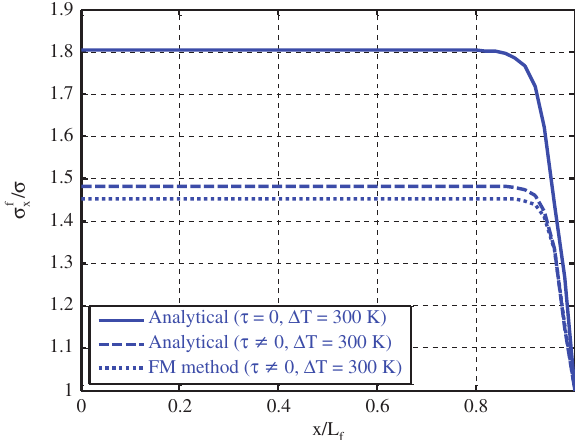
Figure 4: A schematic arrangement of the RVEs in the hybrid nancomposite.